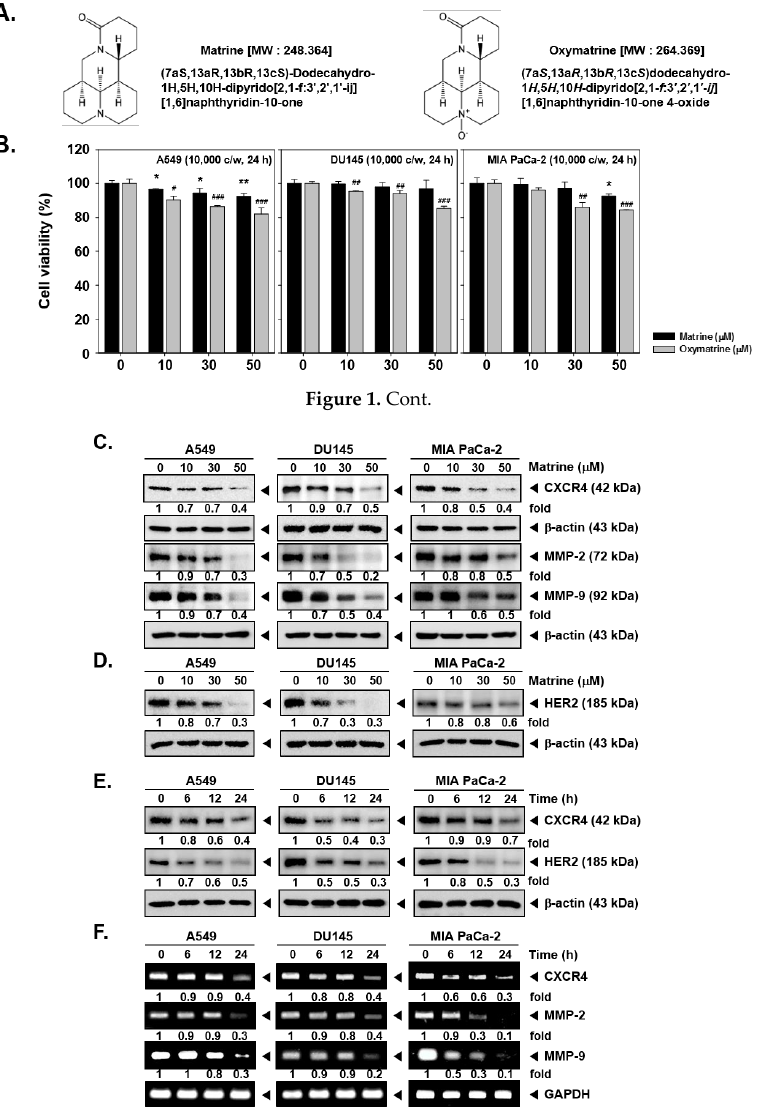
Figure 1. E ff ects of matrine on CXCR4 levels on A549, DU145 and MIA PaCa-2 cells. ( A ) Chemical structure of matrine. ( B ) A549, DU145 and MIA PaCa-2 cells (1 × 10 4 cells / well) were treated with matrine for 24 h. Then cell viability was measured by MTT assay. ( C and D ) A549, DU145 and MIA PaCa-2 cells (5 × 10 5 cells / well) were treated with matrine for 24 h in 37 ◦ C, 5% CO 2 incubator. Cells were harvested and whole cell lysates were prepared for western blot analysis. Proteins were separated on SDS-PAGE gels and transferred to nitrocellulose membranes. Membranes were probed with anti-CXCR4, anti-MMP-2, anti-MMP-9, and anti-HER2 antibodies. The same membranes were stripped and probed with β -actin antibodies. ( E ) A549, DU145, and MIA PaCa-2 cells (5 × 10 5 cells / well) were treated with 50 µ M of matrine for indicated time intervals in 37 ◦ C, 5% CO 2 incubator. Whole cell lysates were prepared for western blot analysis then probed with anti-CXCR4, and anti-HER2 antibodies. Same membranes were stripped to confirm the β -actin levels. ( F ) A549, DU145 and MIA PaCa-2 cells (5 × 10 5 cells / well) were treated with 50 µ M of matrine for several time intervals. mRNA level was measured by RT-PCR. We have used GAPDH as a loading control. Then expression levels of CXCR4, MMP-2, MMP-9 was compared on each cell lines. All experiments were performed independently at least 3 times and representative data are shown. ** p < 0.01, * p < 0.05 vs. non-treated (NT) cells with matrine and ### p < 0.001, ## p < 0.01, # p < 0.05 vs. non-treated (NT) cells with